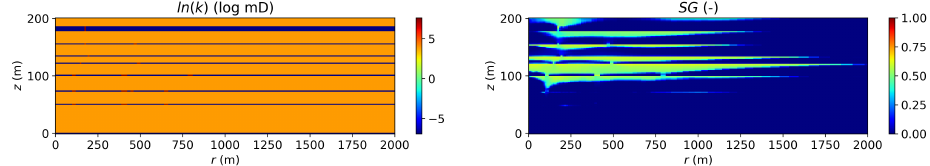
Figure 11. Permeability map and gas saturation prediction in a Sleipner-like